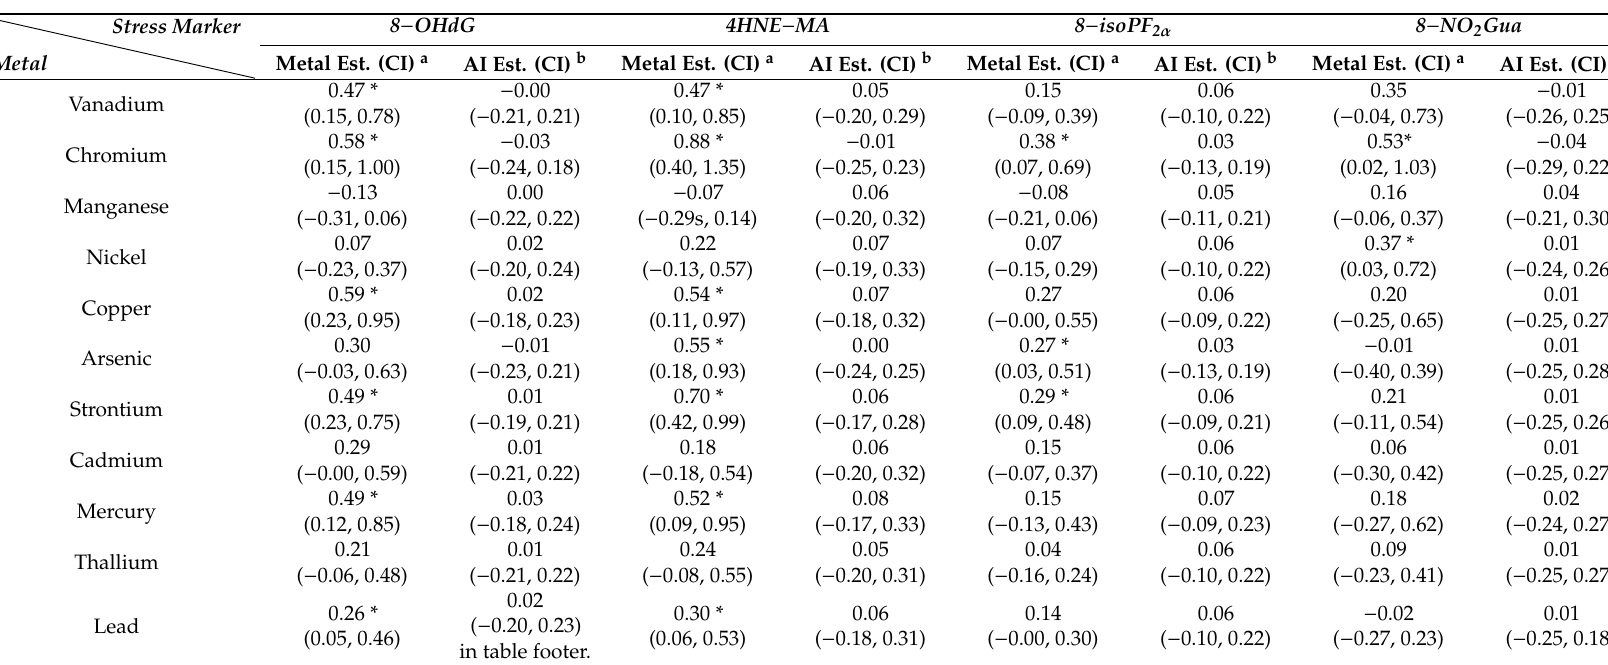
Table 4. The associations between heavy metal exposure and oxidative stress with the antioxidant intake for study subjects in high exposure group (n = 76).